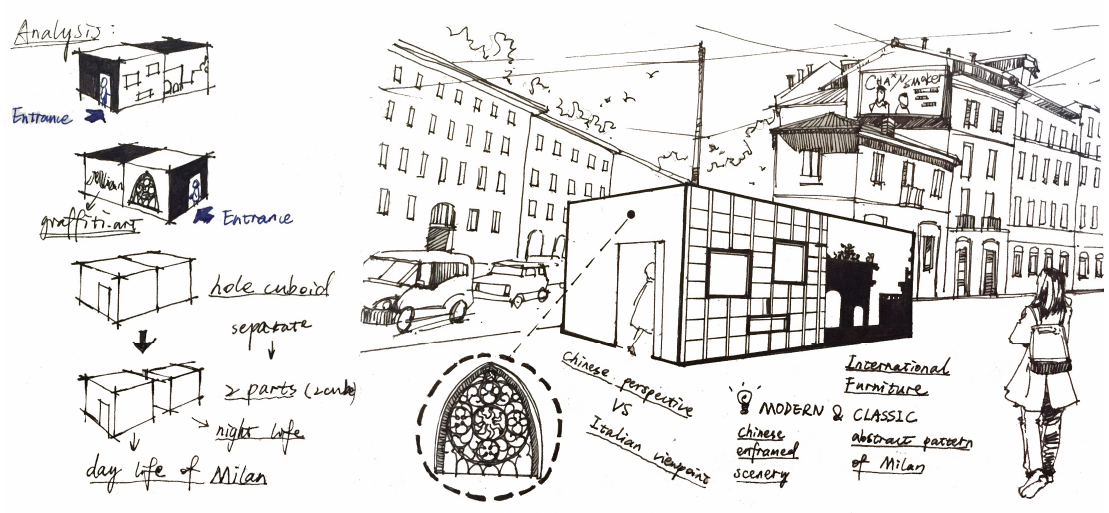
Figure 3. A sketch of the project that valorized the mix of historical and modern souls of the